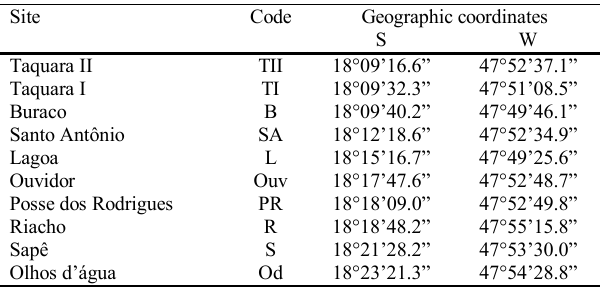
Table 1. Streams sites sampled in the Ouvidor River basin and their geographic